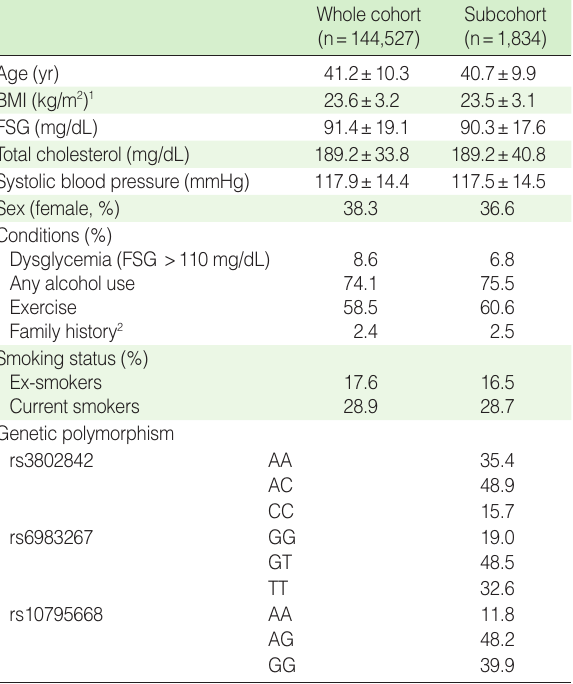
Table 1. General characteristics of study participants: the Korean Cancer Prevention